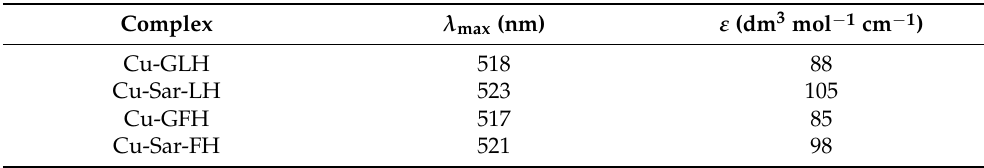
Table 2. The maximum wavelengths and their corresponding molar extinction coefficients of